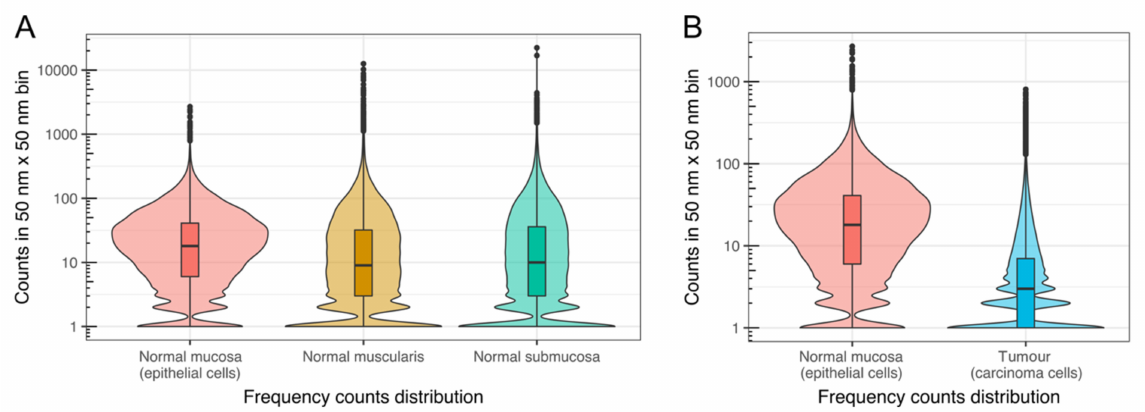
Figure 5. Violin + box plot representations of the localisation signal histograms for nuclei from different regions. A side-by-side comparison is shown between nuclei from ( A ) normal epithelial cells of the mucosa, cells of the submucosa, and of the muscularis layer, and ( B ) between normal epithelial cells of the normal mucosa, and carcinoma cells within the mucosa of a tumour sample. Binning analysis was done in the super-resolved reconstruction images, and signature chromatin density profile distributions were found for each cell type. Horizontal lines in each box plot represent the median value of each one of the distributions. Each distribution is the combination of the replicates (7 for normal submucosa, 2 for normal mucosa, 3 for normal muscularis and 4 for carcinoma cells in the tumour region) for each cell type. Plots of all the replicates from each cell type can be found in Supplementary Figure S2. The horizontal black lines in the middle of the box plots represent the median for each one of the distributions. The values are: mucosa-derived normal epithelial cells 18, muscle cells 9, submucosal cells 13, carcinoma cells